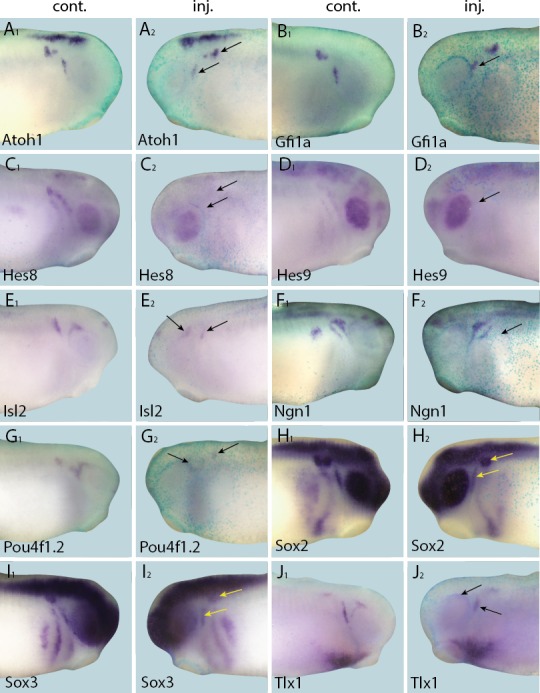
Down-regulation of target gene expression domains after overexpression of Eya1.Tail bud stage embryos (A–J) after unilateral injection of Eya1-GR and DEX induction at neural plate stage (16–18). In each case, lacZ was co-injected as a lineage tracer and panels A1–J1 show the control (un-injected) side and A2–J2 show the injected side. Arrows mark reductions in marker gene expression in placodal derivatives.